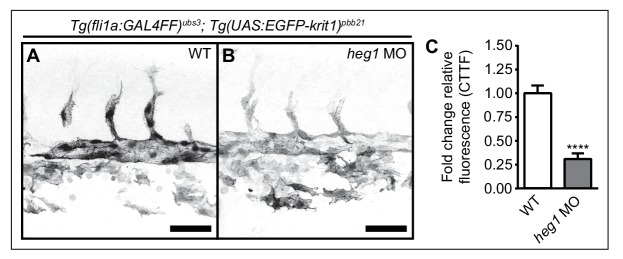
Stabilization of Krit1 protein levels by heg1 in the trunk vasculature.(A–C) Morpholino-mediated knockdown of Heg1 significantly reduces EGFP-Krit1 protein levels in the trunk vasculature of 30 hpf Tg(fli:GAL4FF)ubs3; Tg(UAS:EGFP-Krit1)pbb21 embryos. Scale bars are 50 µm. Mean values ± SEM of three individual experiments are shown. Unpaired t-test was used to compare conditions with control (****p<0.0001).